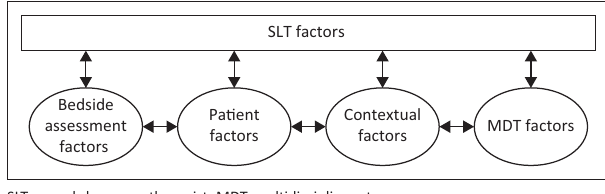
FIGURE 1: Decision-making factors when using a bedside